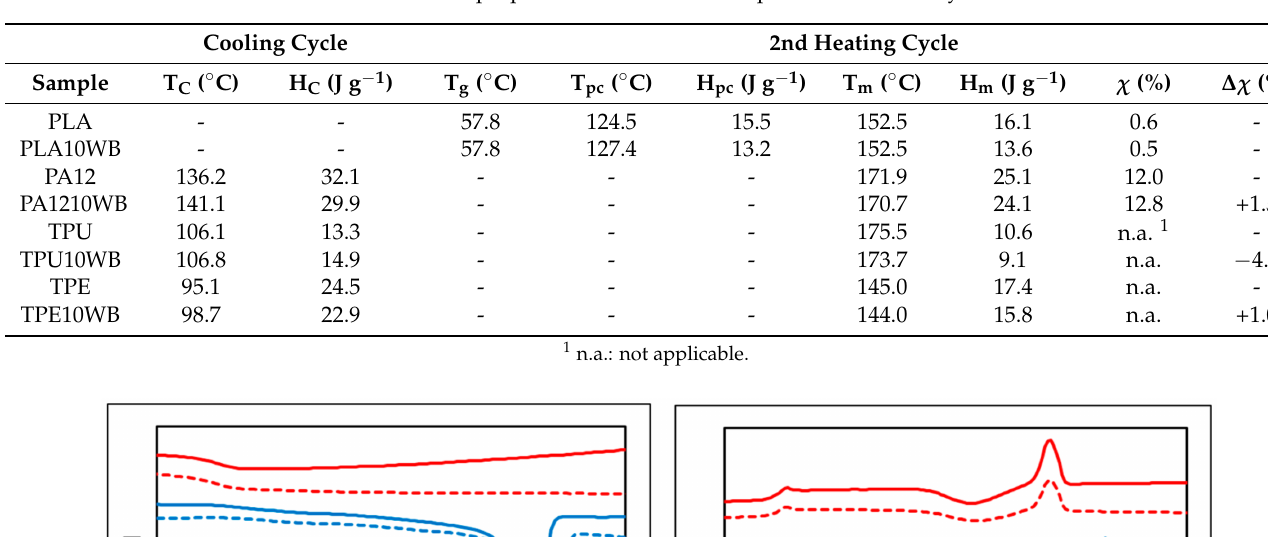
Table 3. Thermal properties of WB-based composites evaluated by DSC.